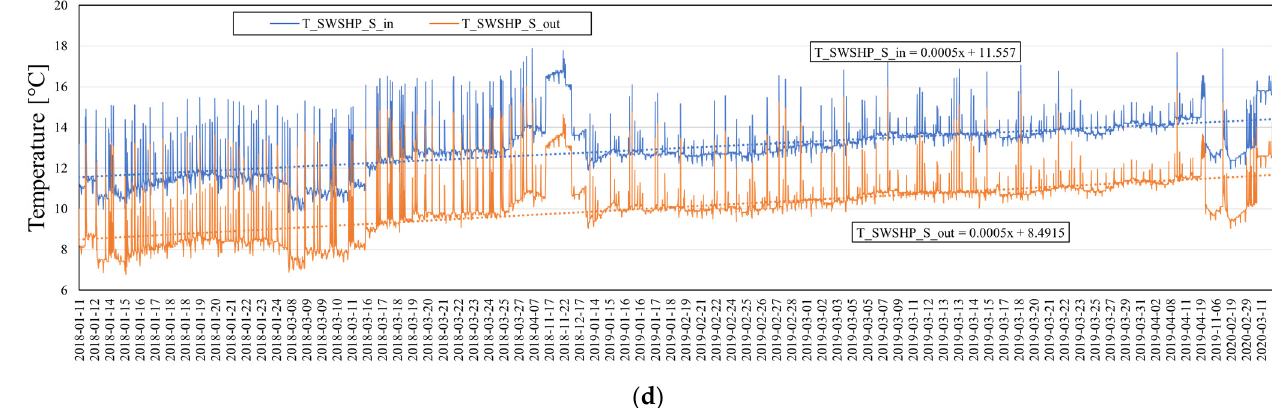
Figure 8. Operation results of the heat pump systems during the heating season: ( a ) load side operation of GSHP; ( b ) source side operation of GSHP; ( c ) load side operation of WSHP; and ( d ) source side operation of WSHP.